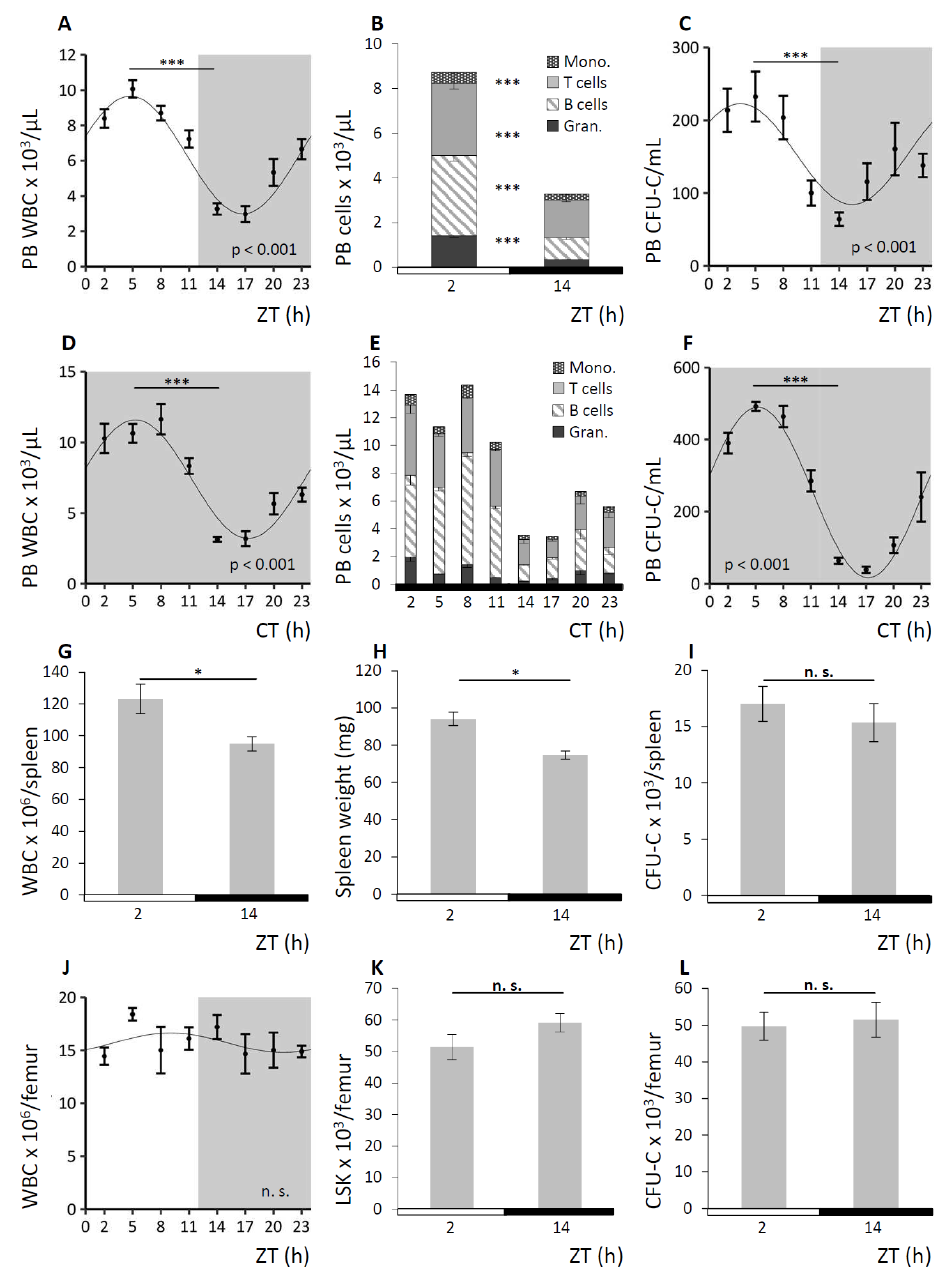
Figure 1. Hematopoietic cell concentrations in peripheral blood (PB) and spleen, but not bone marrow (BM), oscillate in a circadian fashion. Wild-type (WT) mice were kept under conditions of 12 h light/12 h darkness (LD) indicated by half white/half grey backgrounds or half white/half black bars below the graphs and under constant darkness conditions (DD) displayed by grey backgrounds or solid black bars below the graphs. Cosinor analysis of circadian rhythms was performed for all 24 h experiments (see Table 1 for rhythm characteristics). Mice were and analyzed for mature and immature cell contents in PB ( n = 8 – 16 mice per time point), spleen ( n = 14 mice per time point), and BM ( n = 10 mice per time point). A – C. PB was assessed under LD conditions for white blood cell (WBC) count ( A ), leukocyte subpopulations ( B ), and CFU-C concentrations ( C ). D–F. PB was analyzed under DD conditions for WBC count ( D ), leukocyte subpopulations ( E ), and CFU-C concentrations ( F ). G–I. Splenic WBC counts ( G ), spleen weight ( H ), and CFU-C content ( I ) were determined at zeitgeber time (ZT) 2 and ZT14. J–L. BM WBC counts over time ( J ) as well as LSK ( K ) and CFU-C content per femur ( L ) at ZT2 and ZT4 were assessed. Asterisks: * p < 0.05, *** p <